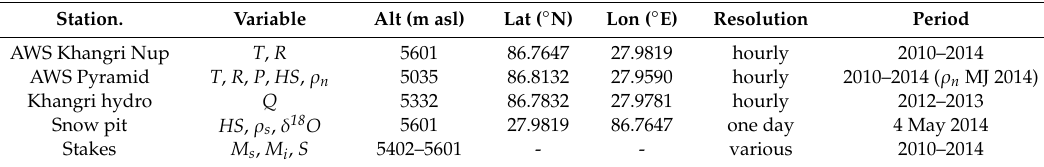
Table 1. Data available. T is temperature, P is precipitation, S is snow height, R solar radiation, Q is flow rate, M i is ice melt, M s is snow melt, ρ s is snowpack density, and ρ n is new snow density,